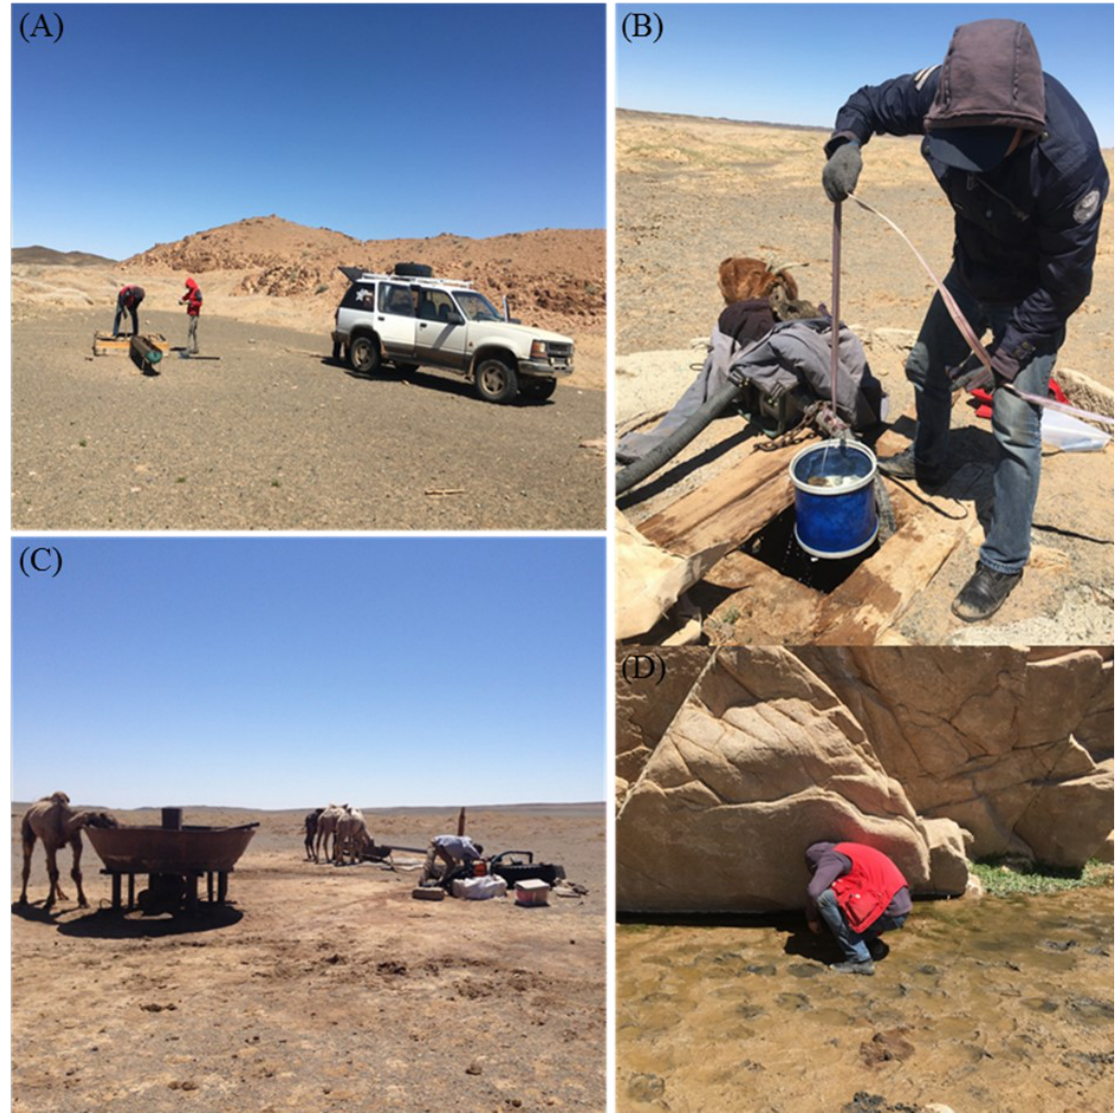
Fig. 2. Water sampling in the Shuteen area. A and B. drinking water well, C. livestock watering well, D. natural